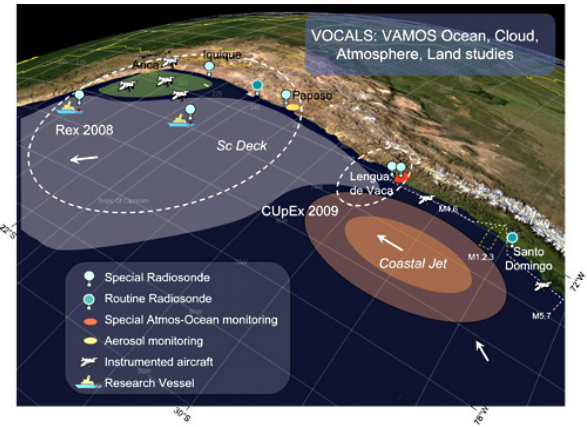
Fig. 1. An overview of the areas targeted by and platforms em- ployed in the VOCALS field experiments. VOCALS-REx took place in October–November 2008 in a large coastal and open ocean area off southern Per´u and northern Chile (down to 25 ◦ S), including two research vessels, five fully instrumented aircrafts and one land supersite (Paposo). VOCALS-CUpEx took place in November– December 2009 in the coastal area around 30 ◦ S (Lengua de Vaca and the bay of Tongoy) and included 7 research missions off central Chile during 2010/2011 (M1–M7). The map also shows some key locations and atmospheric features over the southeast Pacific: the stratus cloud deck, the coastal low-level jet and the southerly flow around the subtropical anticyclones.